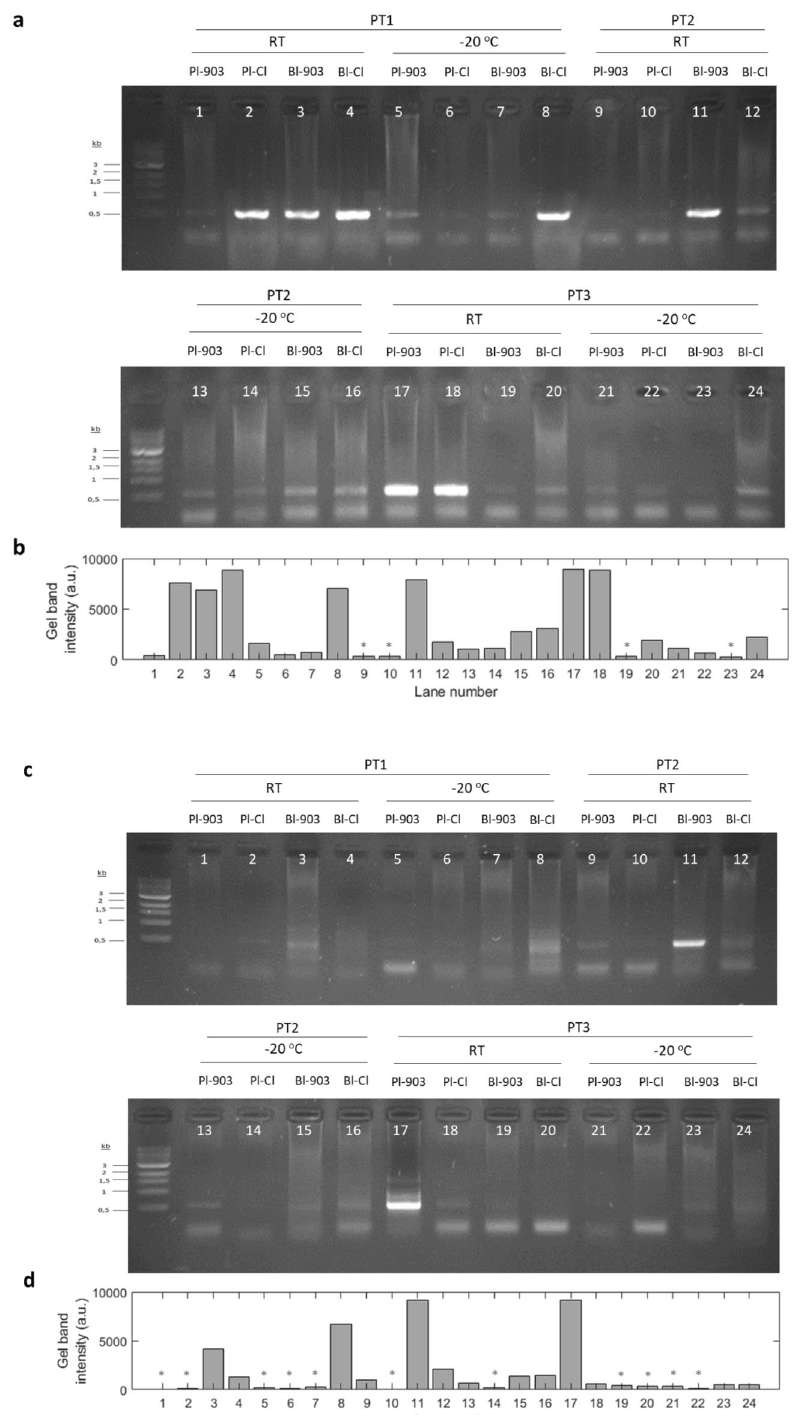
Figure 1. Representative results of PCR amplification in samples PT1, PT2 and PT3 at the different storage and temperature conditions analysed. In upper panels, images correspond to the migration pattern of the PCR products ( a ), and histograms represent their measured MFI ( b ) after 255 days of storage. In lower panels, similarly, images correspond to the migration pattern of the PCR products ( c ), and histograms represent their measured MFI ( d ) after 360 days of storage; Pl-903: plasma sample stored in 903 Protein Saver Card; Pl-Cl: plasma sample stored in FTA Classic Card; Bl-903: blood sample stored in 903 Protein Saver Card; Bl-Cl: blood sample stored in FTA Classic Card. (*) Negative